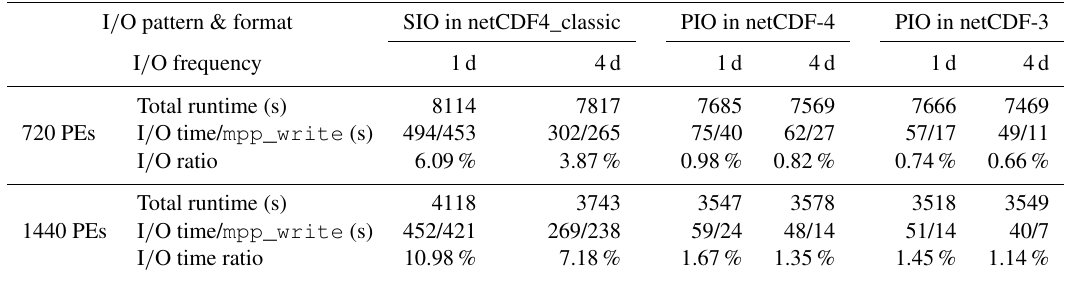
Table 6. The time metrics of 0.1 ◦ model in 720 and 1440 PE runs with less I / O frequencies, i.e. write per 1 and 4d in 8d simulations. SIO represents the original single-threaded write; PIO represents parallel shared write. The I / O time composes of contributions from mpp_open , mpp_read , mpp_write and mpp_close . The I / O time ratio is given between the I / O time and total runtime. All values are taken from the maximum wall time among all